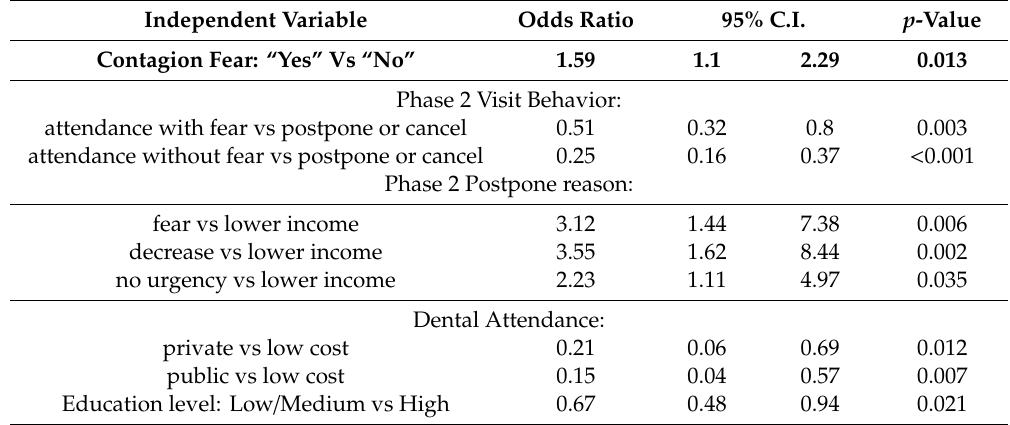
Table 3. Odds ratio estimates of variables associated to the influence of SARS-CoV-2 on upcoming dentist